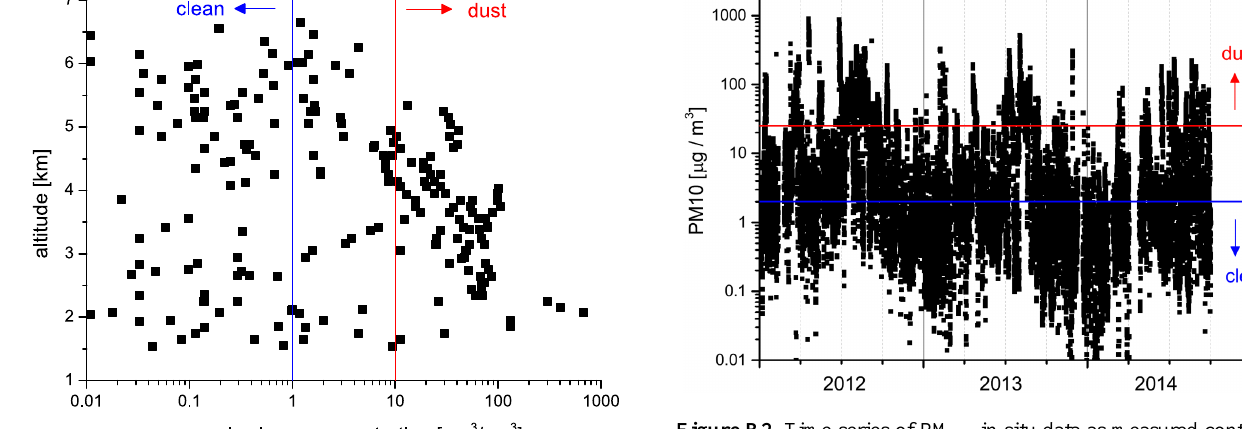
Figure B2. Time series of PM 10 in situ data as measured continu- ously at Izaña (2012–2014).